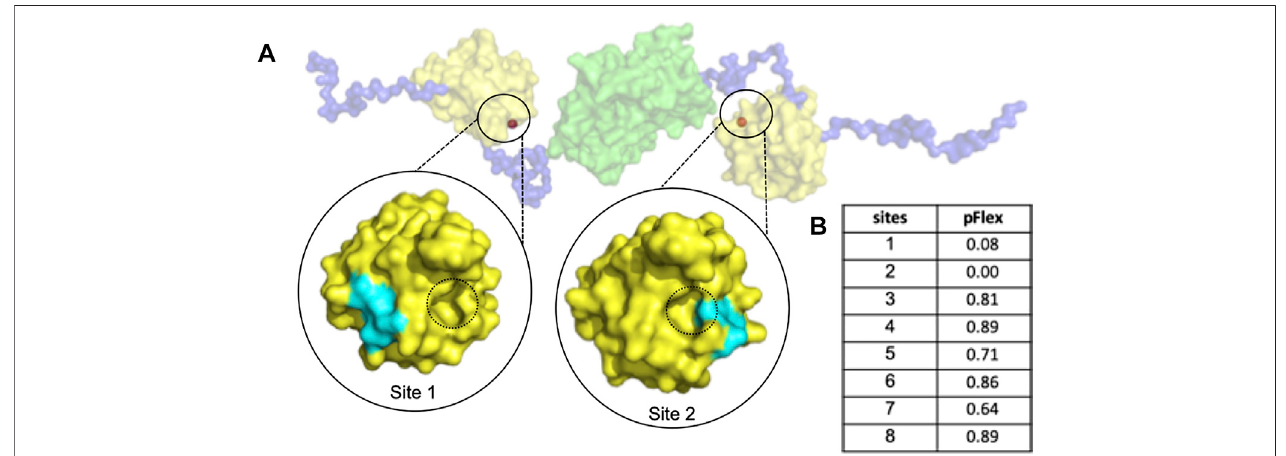
FIGURE 1 | The dimeric MERS-CoV N protein possesses a druggable sites for allosteric modulator design. (A) The structure of dimeric N protein was obtained by SAXS experimentfrom previouspublication (Lin etal.,2020)inwhichtheNTD,linker anddimericCTDwereshowninyellow,blueand green, respectively. Thepredicted allosteric sites were shown in orange and highlighted in black circles. Forsimpli fi cation, only the sites with potent pFlex were shown. The interface of non-native PPIwas indicatedwithblackdottedcircles. (B) ThepFlexvaluesofallpredicted sites.pFlexindicates overall fl exibilityoftargetprotein maybeaffectedbythebindingligand to the sites where the p -value is lower than 0.05.